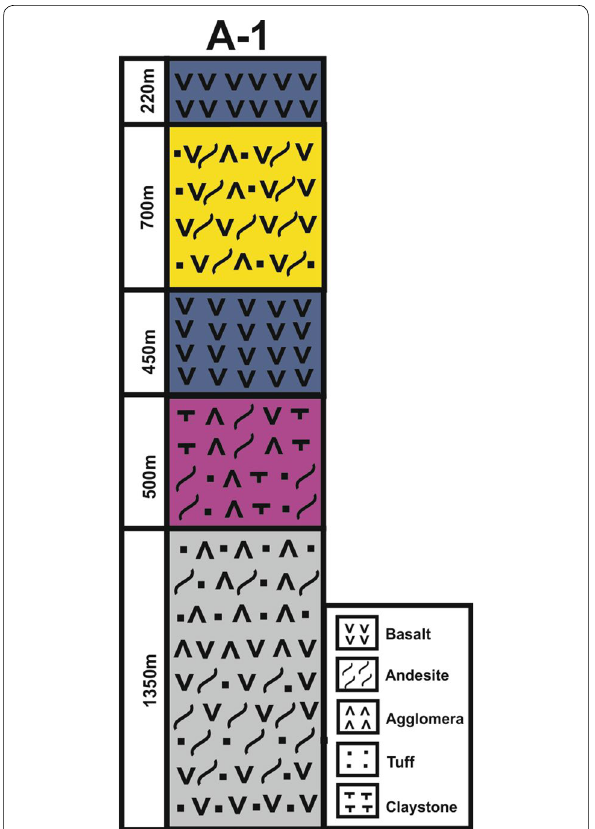
Fig. 10 Lithological section based on petrological analysis of rock samples from the borehole A-1 drilled in the EKP. The borehole reached a depth of more than 3 km, and it was drilled in 1999 by the Turkish Petroleum (TPAO). For borehole location, see Fig.